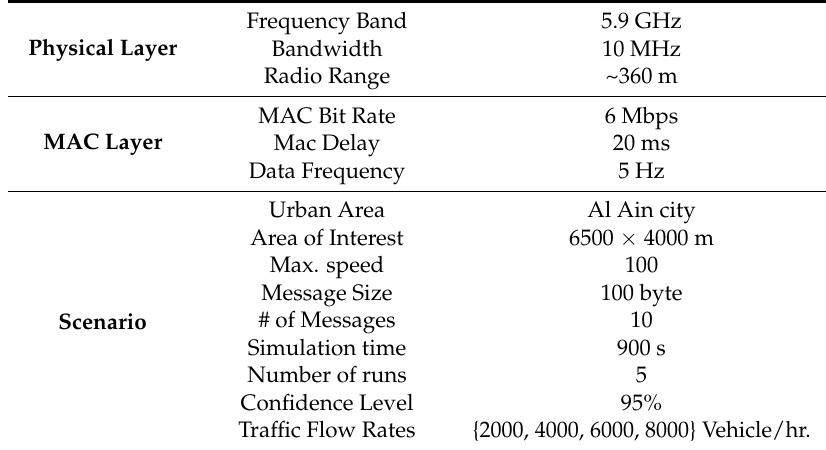
Figure 5. SUMO NetEdit Map. Table 1. Simulation